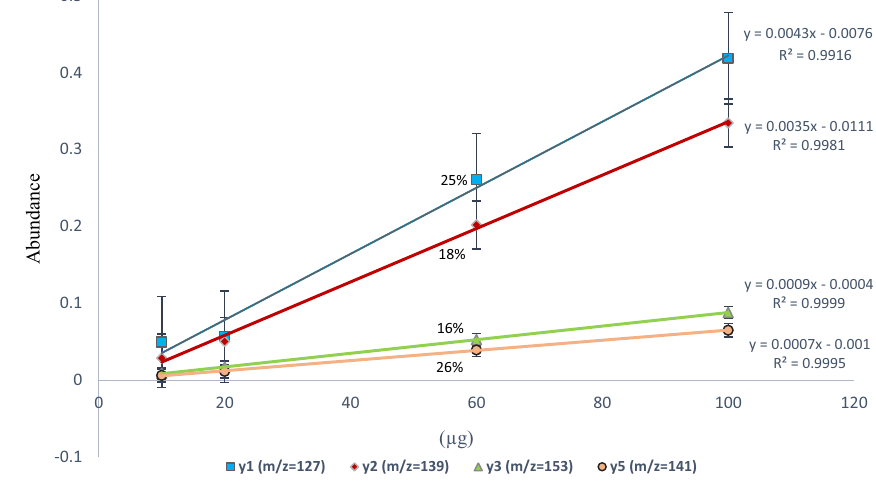
Fig. 3 Quantitative cor- relation plot of the